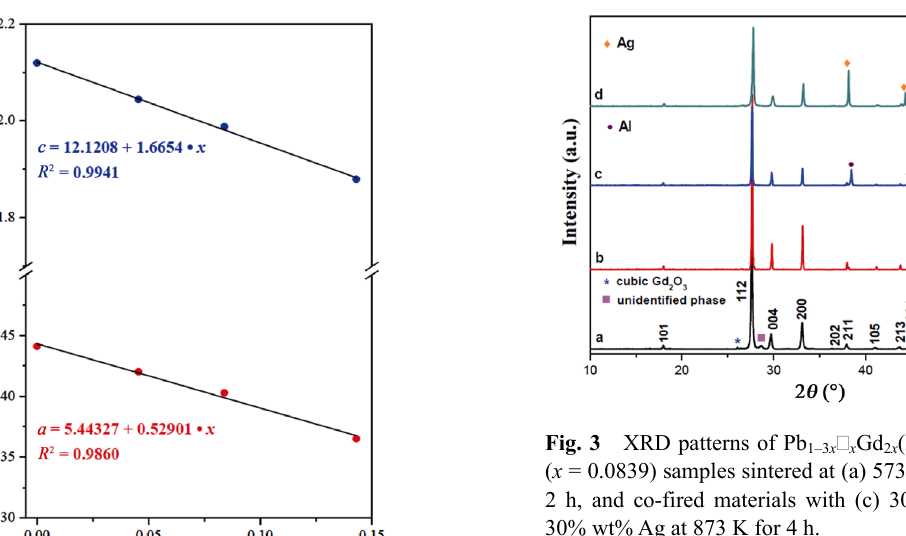
Fig. 1 XRD patterns of PbMoO 4 and Pb 1–3 x (cid:0) x Gd 2 x (MoO 4 ) 1–3 x (WO 4 ) 3 x ( x = 0.0455, 0.0839, 0.1430) materials sintered at 1173 K within the range of 2  from 10° to 60° (a) and the (112)/(004)/(200) diffraction peaks in the rage of 2 θ from 25° to 35° (b).